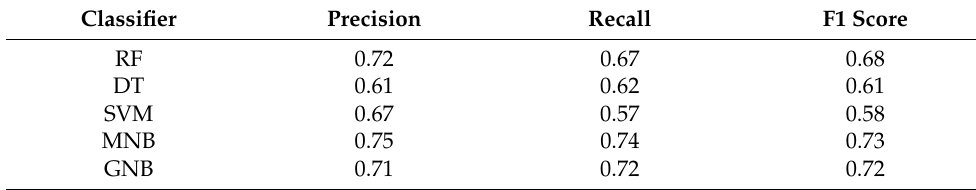
Table 3. Macro-average by using count